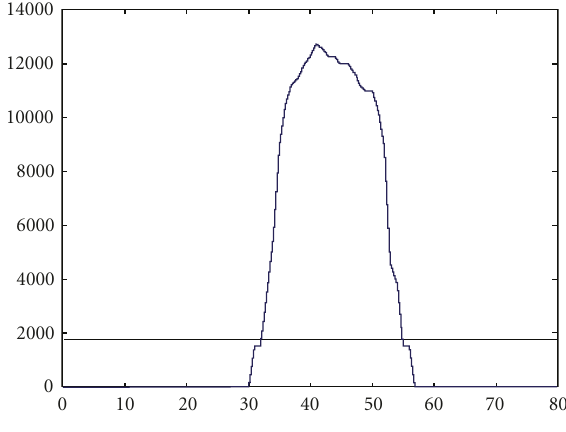
Figure 5: Vertical projection of Figure 4(b).